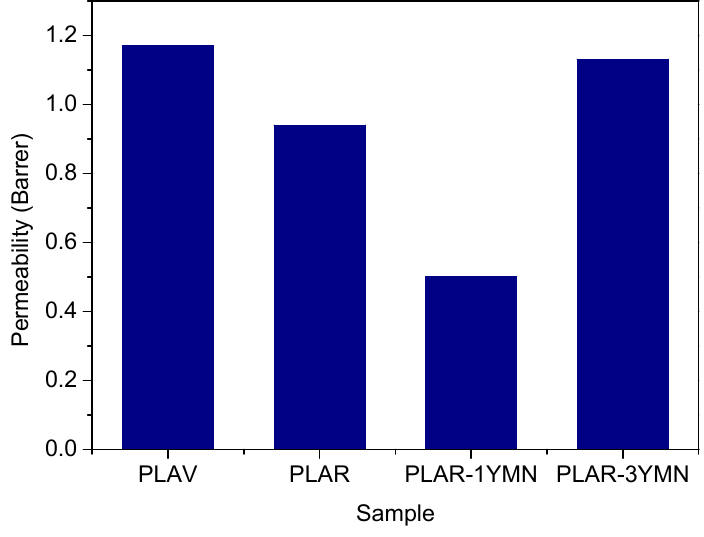
Figure 10. Water vapor transmission rate of the different materials.